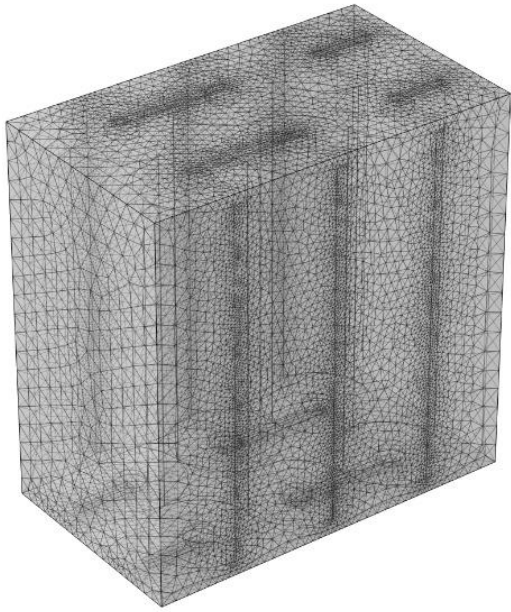
Figure 5. Model mesh realised.